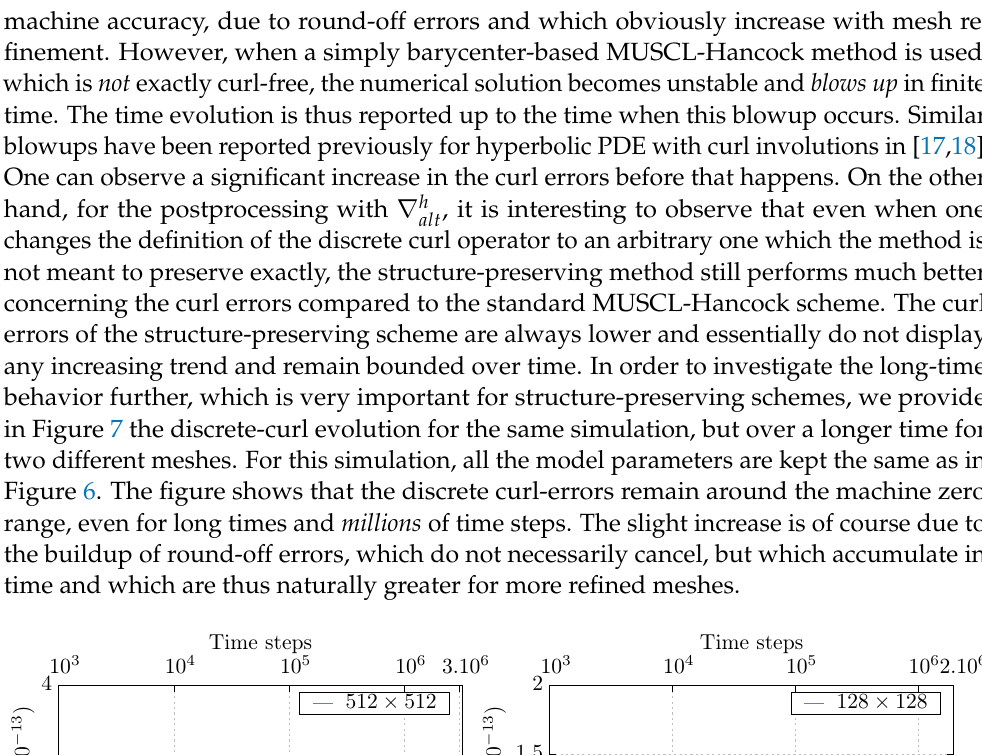
512 grid, while the right figure is for a ×